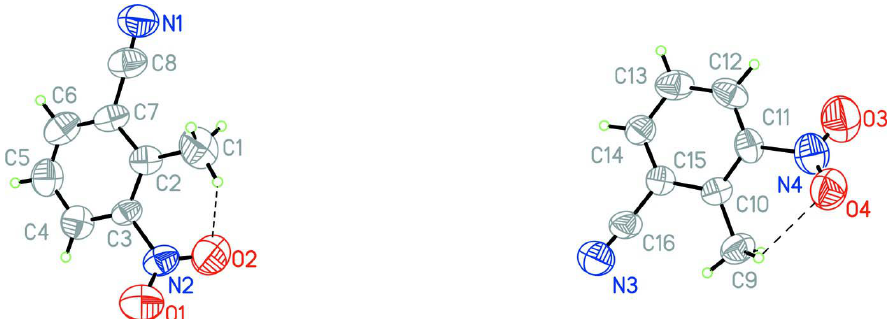
Figure 1 The molecular structure of the title molecule, with the atom-numbering scheme. Displacement ellipsoids are drawn at the 30% probability level. Hydrogen bonds are shown as dashed